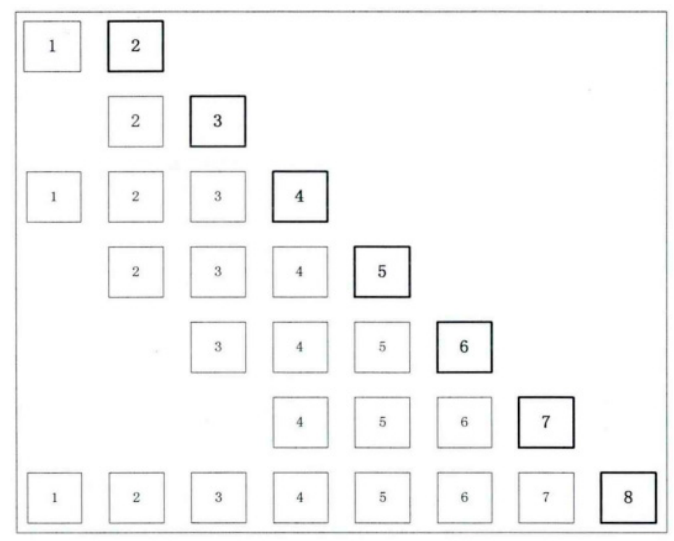
Figure 1. Schematic diagram of the online multiscale (OLMS) sliding window.